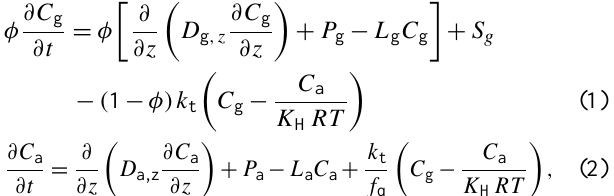
Fig. 1. Vertical domains and physical/chemical processes repre- sented by